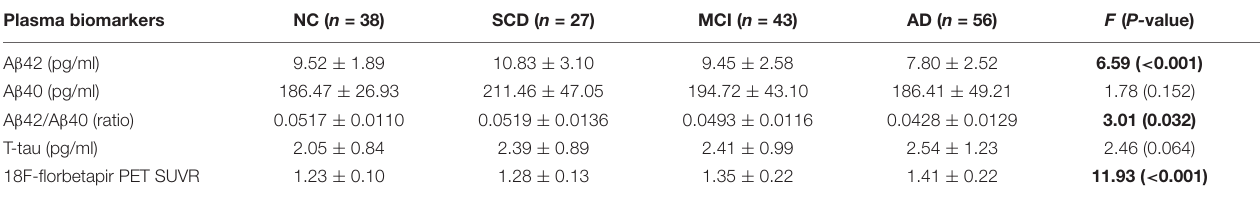
TABLE 3 | Plasma A β 42, A β 40, A β 42/A β 40, t-tau, and 18F-florbetapir PET SUVR for NC, SCD, MCI, and AD in individuals with A β -PET (+).